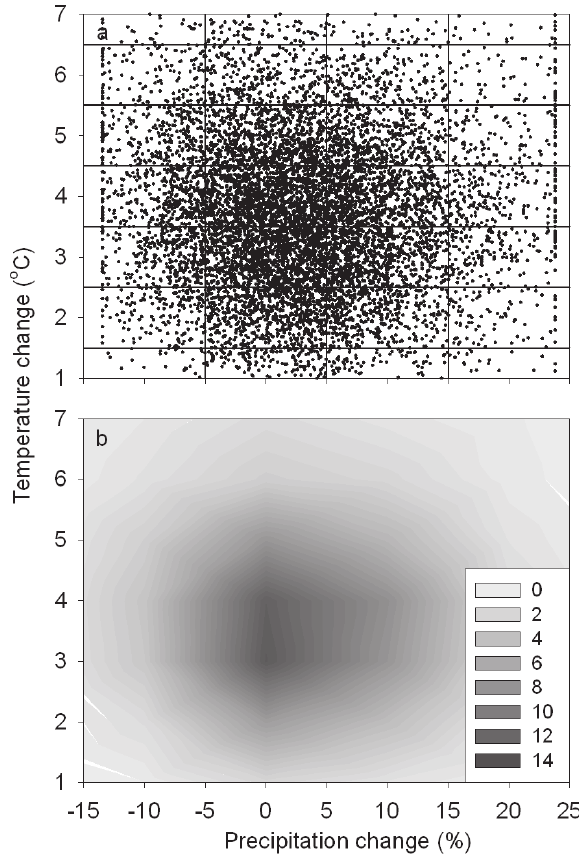
Fig. 1. Projections of annual mean change in temperature and pre- cipitation for Denmark for the years 2061–2080 for the A1B emis- sion scenario (a) , and the joint probability density function (PDF) obtained based on number of observations within each 1 ◦ C × 10% cell (b) . The scale for shading in (b) shows the percentage of ob- servations in each of the 1 ◦ C × 10% cells (data from Harris et al.,